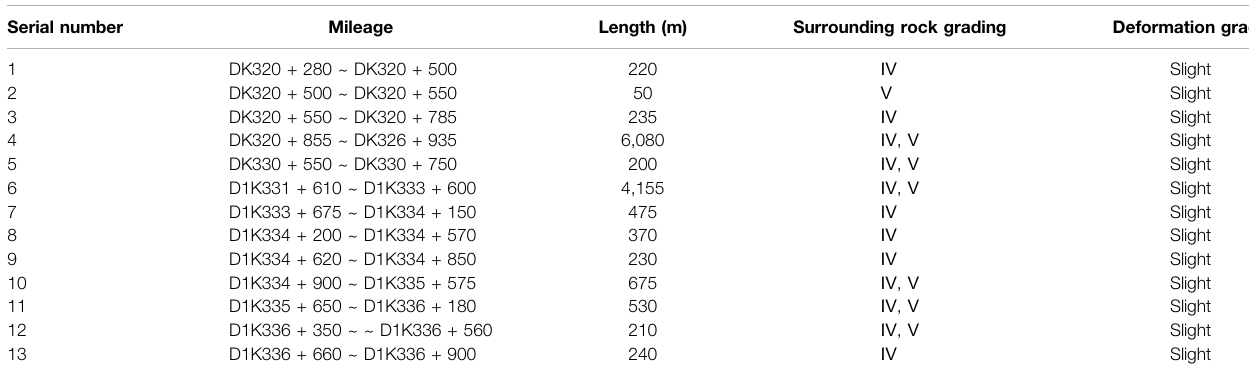
TABLE 4 | List of large deformation sections of soft